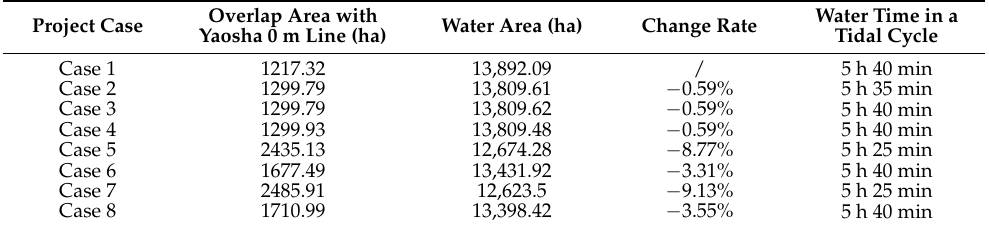
Table 3. The changes of the water area and water time of Yaosha in different reclamation